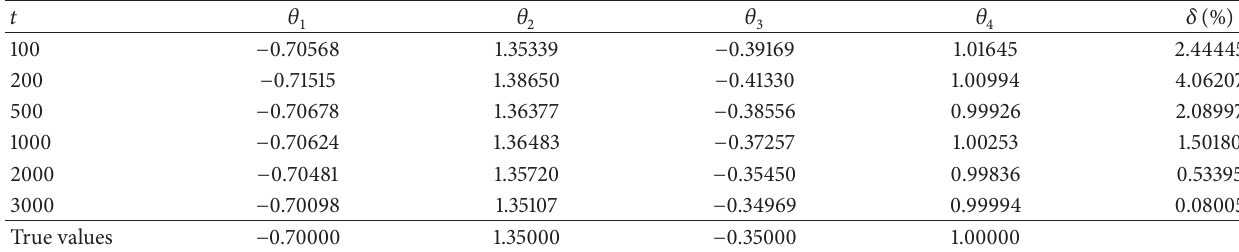
Table 1: The parameter estimates and errors ( 𝜎 2 = 0.20 2 ).